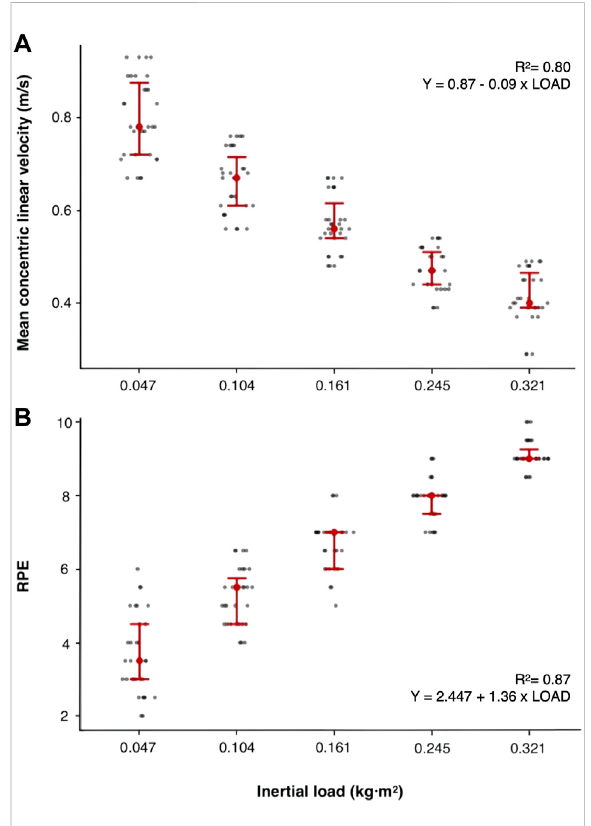
FIGURE 1 (A) Flywheel Load-Velocity pro fi le, and (B) Flywheel Load- RPE pro fi le during the fl ywheel squat